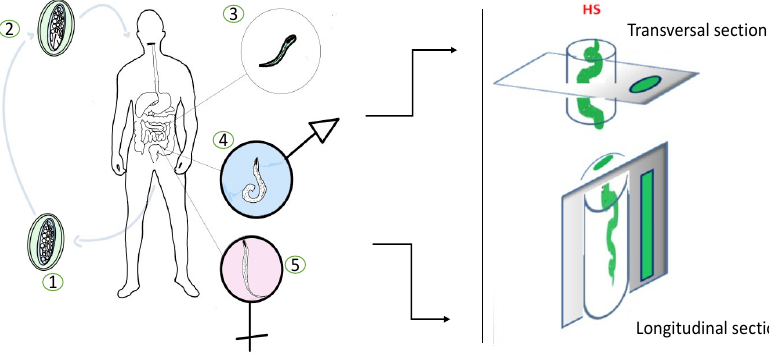
Figure 3. Life cycle of EV in human and intestinal sampling for histological examination. (1) Eggs on perianal folds. Larvae inside the eggs mature within 4 to 6 h. (2) Embryonated eggs ingested by human. (3) Larvae hatch in small intestine. (4) Adults in lumen of cecum. (5) Gravid female migrates to perianal region at night to lay eggs. HS—histological sections.